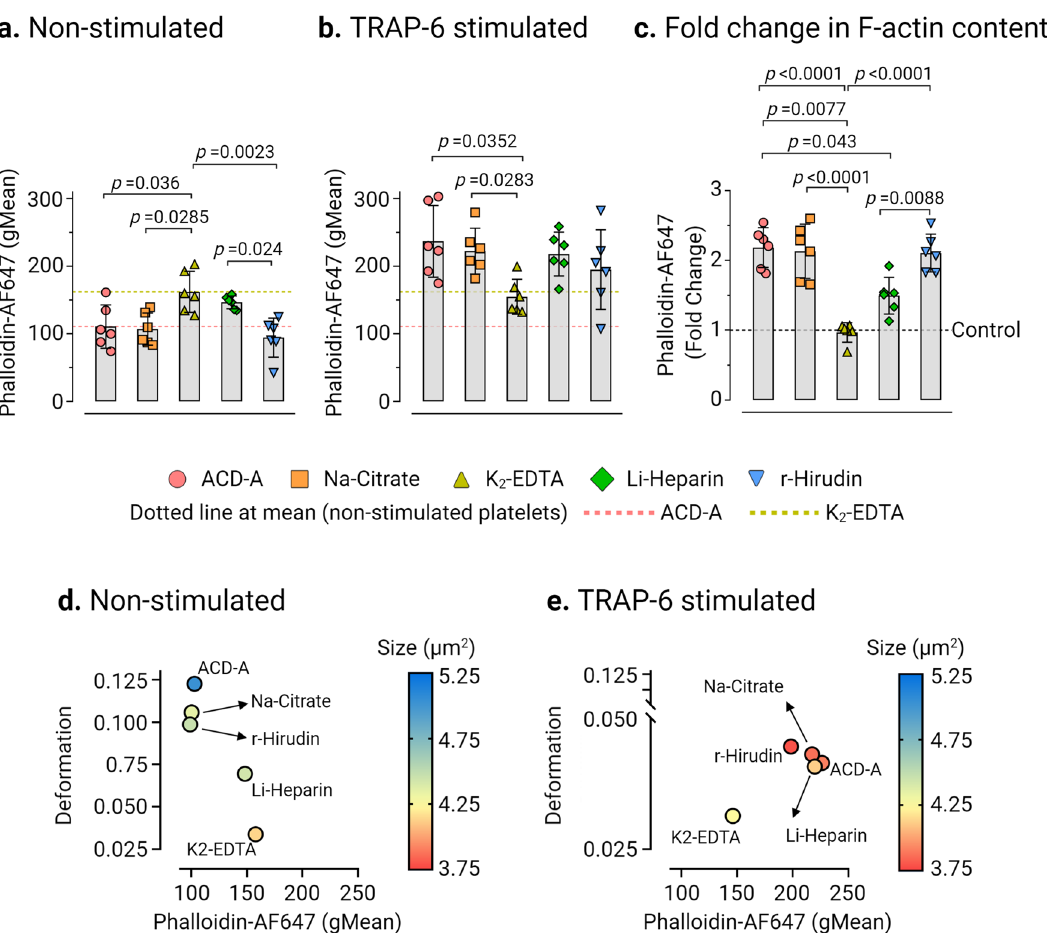
Fig. 5 The change of F-actin content in platelets is an indicator of platelet deformation. Comparison of platelet F-actin (Phalloidin AF647 fl uorescence, gMean) measured by fl ow cytometry in a non-stimulated and b TRAP-6 stimulated platelets in different ex vivo anticoagulants. Fold change in phalloidin binding ( c ) after stimulation with TRAP-6, where control baseline = 1 and plots show mean ± SD from n = 6 donors. Multivariate analysis plots of continuous variables from RT-FDC and fl ow cytometry, ( d ) and ( e ) of non-stimulated and TRAP-6 stimulated platelets, respectively, displaying the relationships between platelet deformation, size, and the F-actin content in different ex vivo anticoagulants, shown as a measure of phalloidin binding. (Data represents median values of individual variables from n = 6 donors). Statistical assessment was performed by applying the mixed-effects model (restricted maximum likelihood, REML) followed by Tukey ’ s multiple comparisons test, with single pooled variance and p < 0.05 was considered signi fi